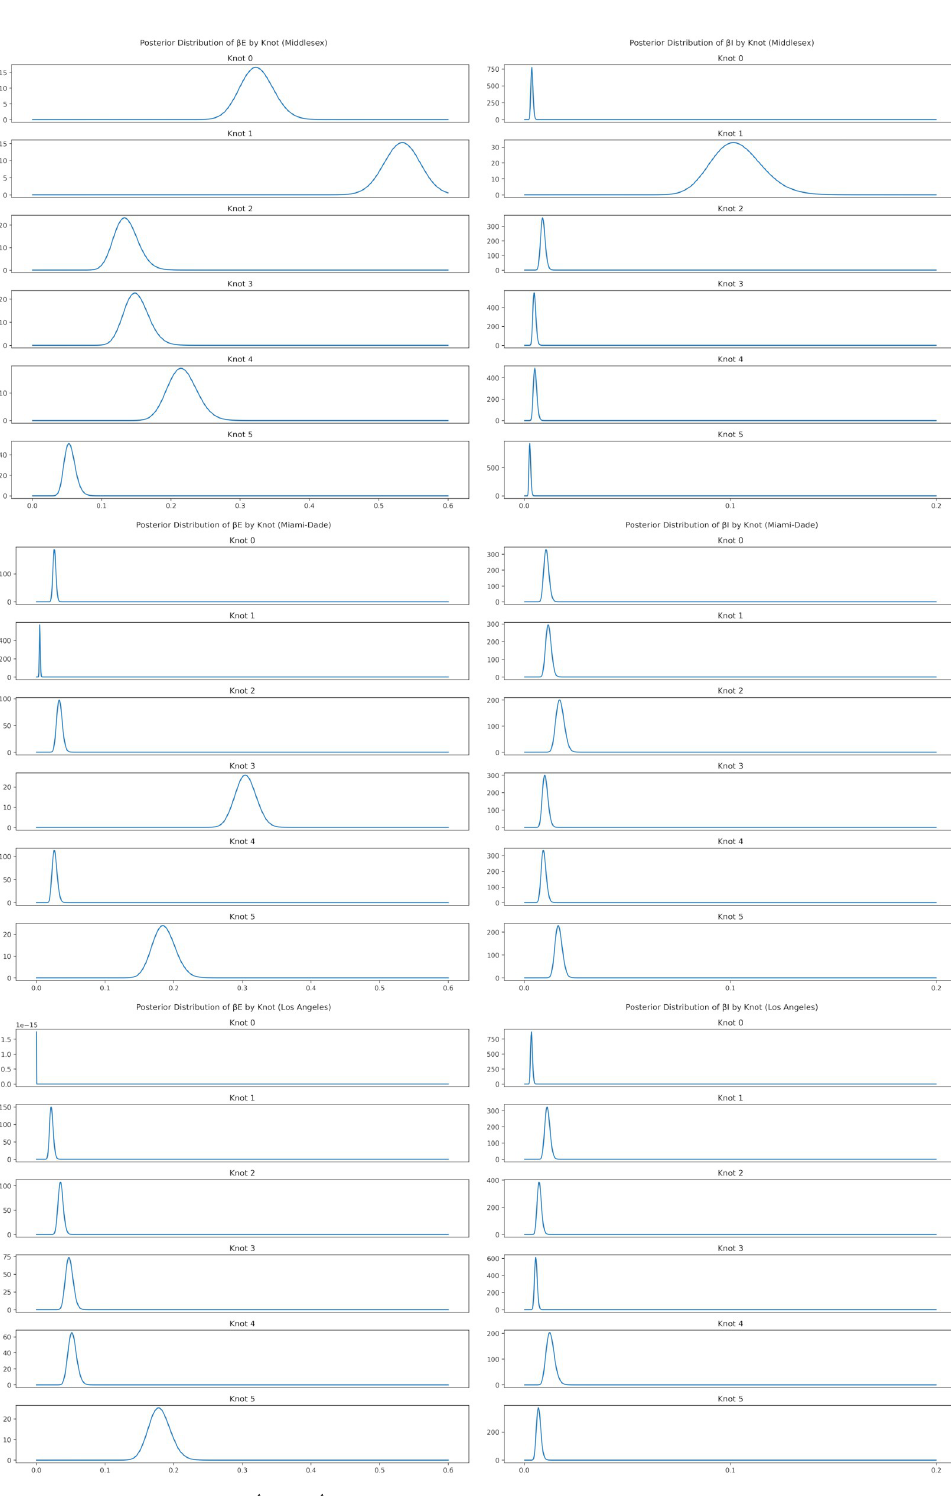
and b t n at each change point during simulation. E I